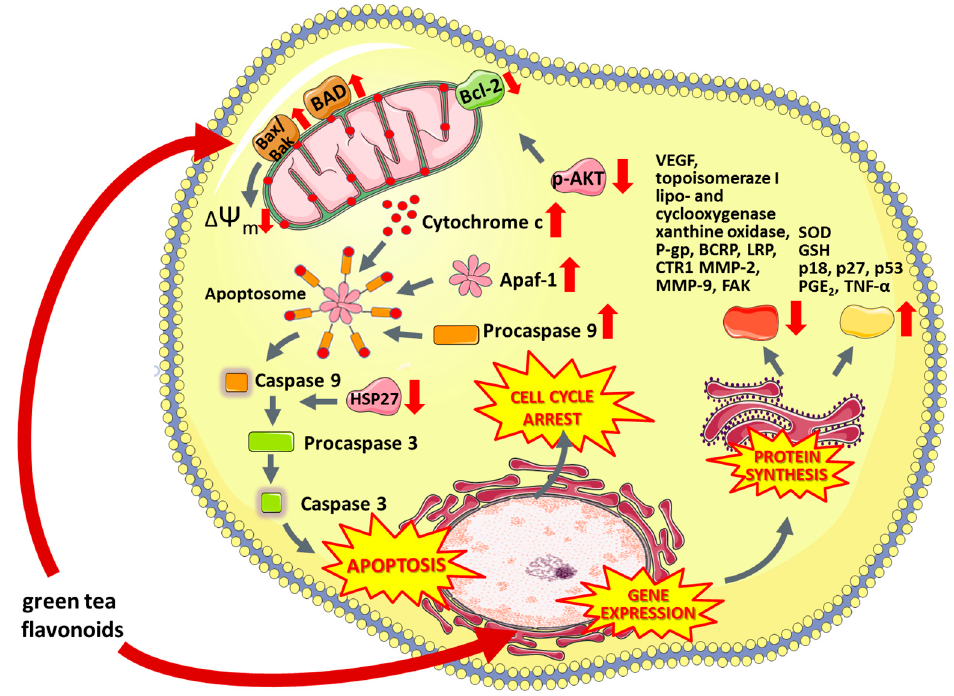
Figure 4. The multi-level anti-cancer activity of green tea flavonoids. ΔΨ m—Mitochondrial